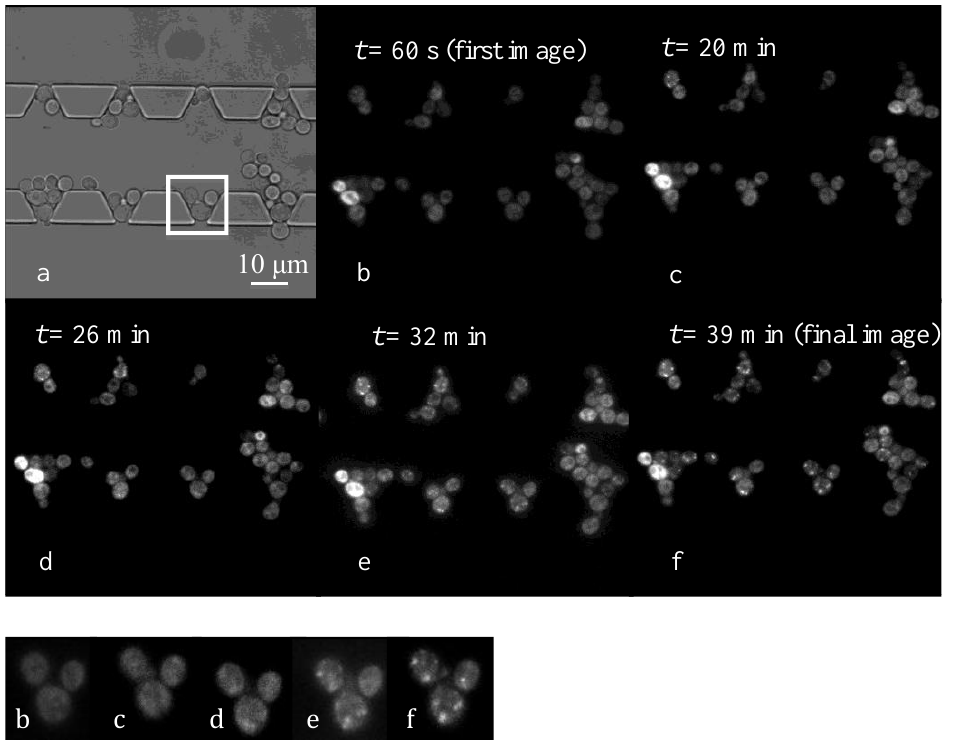
Figure 5. Trapped cells were exposed to the 25 nL min −1 flow rate of arsenite. ( a ) Bright field microscope image of one trapping segment; ( b ) first fluorescence image of the segment at the treatment initiation at t = 60 s; images ( c – f ) were taken from the same field of view at different time points with 6-minute time intervals; image ( f ) was the last image taken at the final time point. The increase in the number of aggregates is clearly shown in the image sequence. The image sequence at the bottom from the same image series ( b – f ) shows the aggregate formation for the cells trapped in one of the pockets [pocket in image ( a ) inside the white